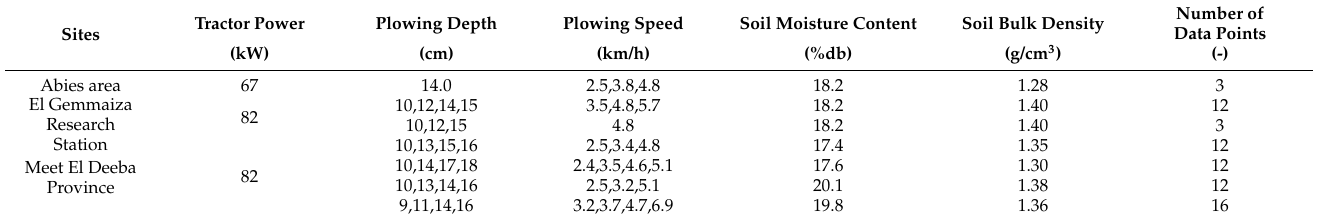
Table 1. Number of data points and levels of plowing depth, tractor power, soil bulk density, plowing speed, and soil moisture content in the experimental